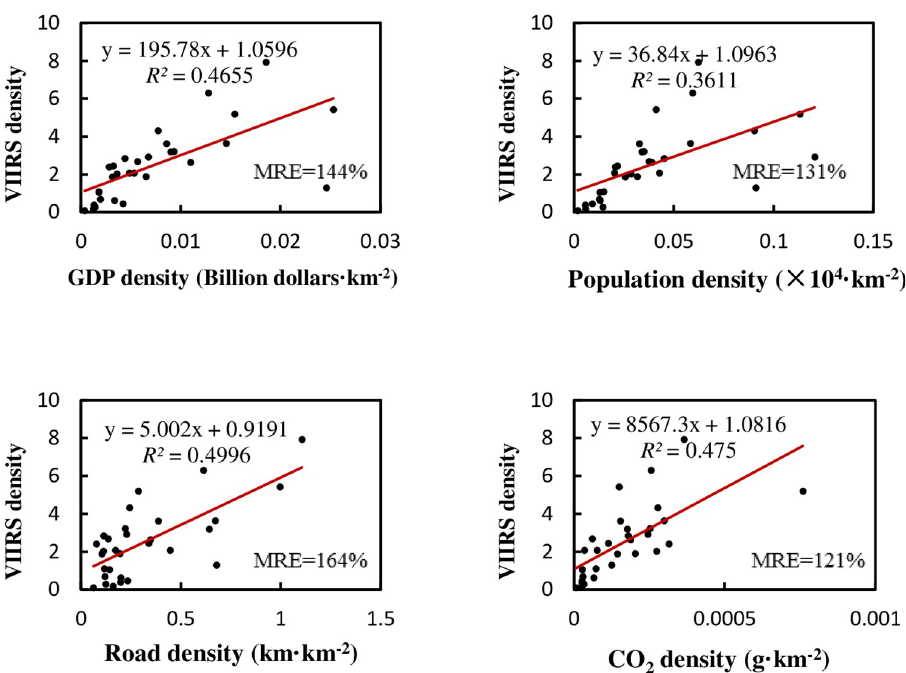
Fig 8. Regression relationship between NTL density and density of various elements in state-level administrative regions of India after excluding two megacities.